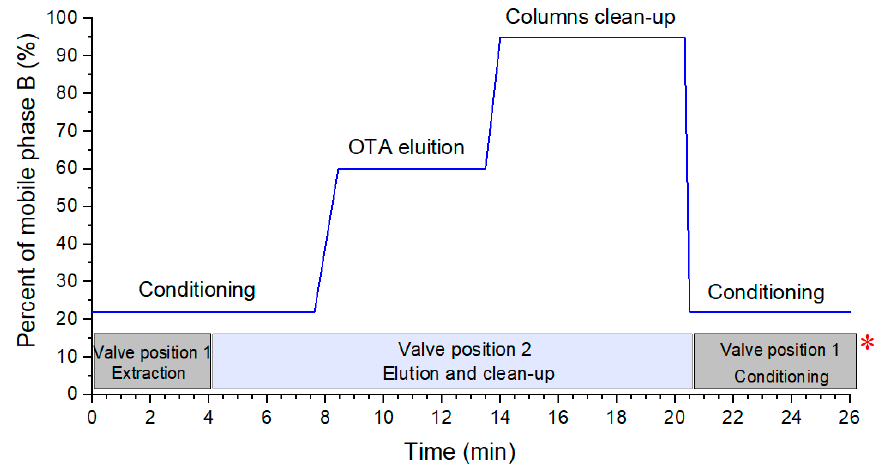
Figure 1. Step elution gradient for the analysis of OTA (Ochratoxin A) by an extraction microcolumn coupled to UPLC–MS / MS, indicating the mobile phase composition in the UPLC pumps, A: H 2 O:0.1% formic acid and B: ACN (Acetonitrile): 0.1% formic acid (blue line). The box below the gradient indicates the configuration of the switching valve (*).